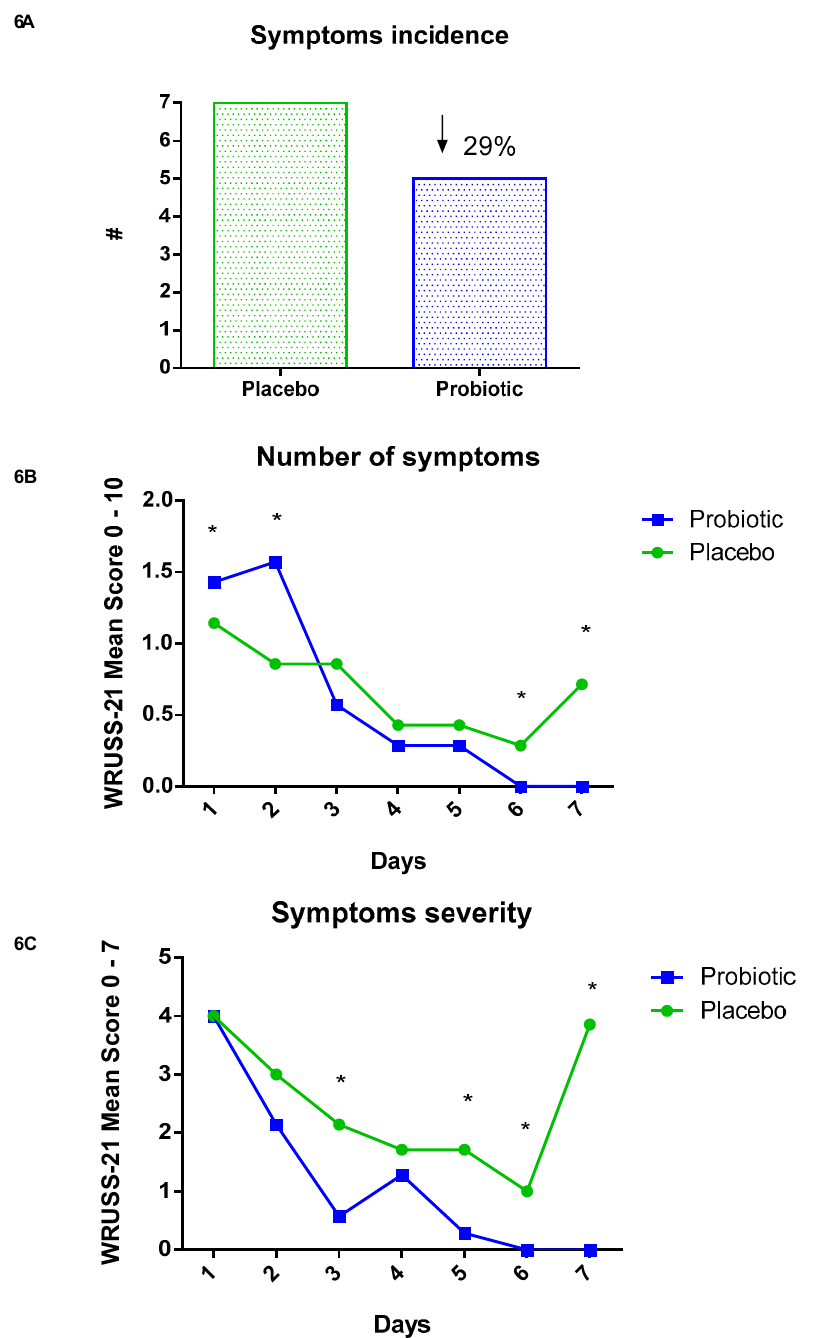
Figure 6. Wisconsin Upper Respiratory Symptom Survey (WURSS—21). Data presented as # and mean of symptoms and severity. Placebo ( n = 7) and probiotic ( n = 7). The comparison between groups was performed through the Student t-test. ( A ) Symptoms incidence. ( B ) Number of symptoms. ( C ) Symptoms severity. * Difference between groups.